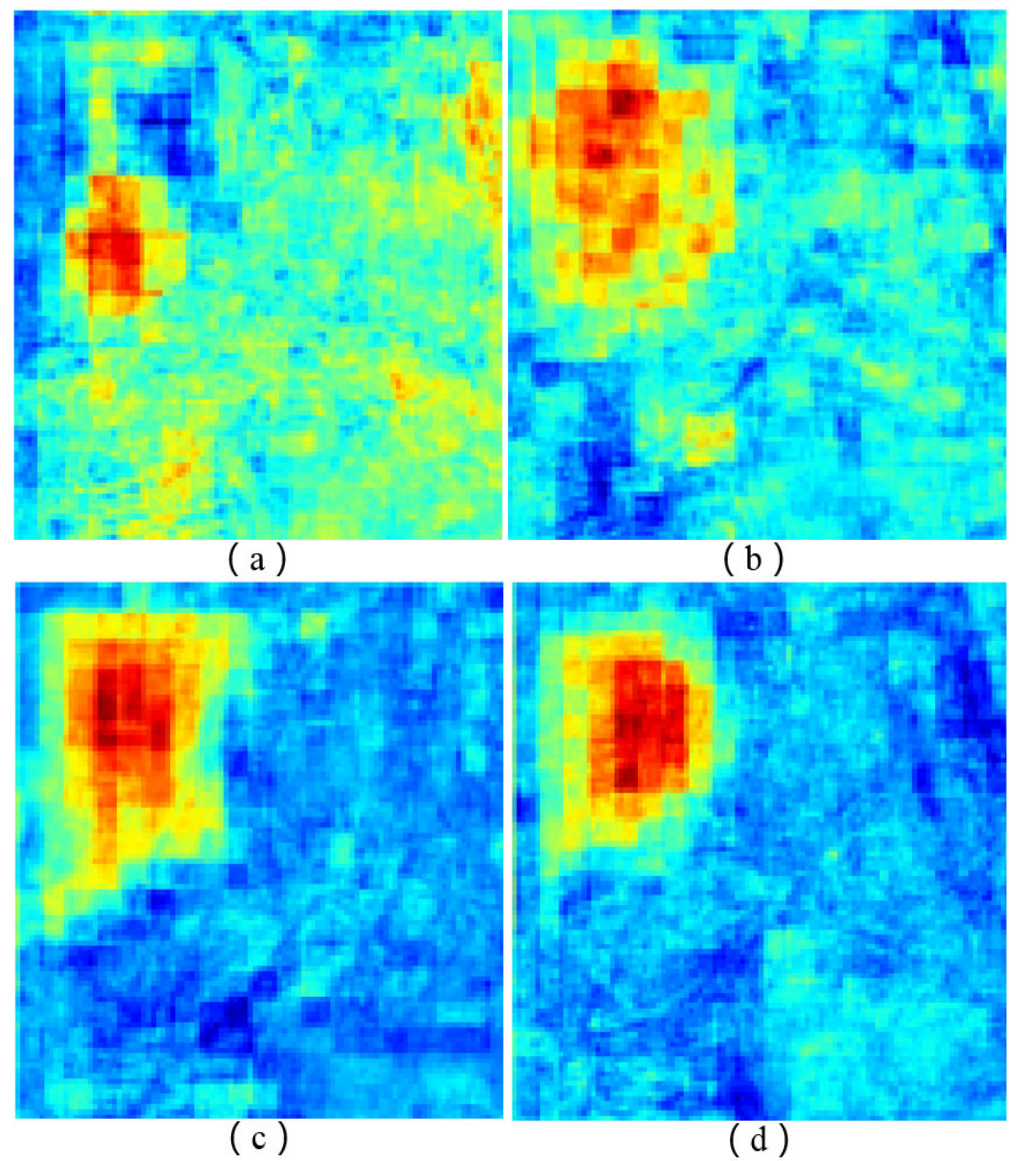
Figure 12 . Feature heat maps of different models. ( a ) feature heat map of the Bands_3 model, ( b ) feature heat map of the Bands_4 model, ( c ) feature heat map of the Bands_4_sub model and ( d ) feature heat map of the Bands_4_sub_SAMB model.